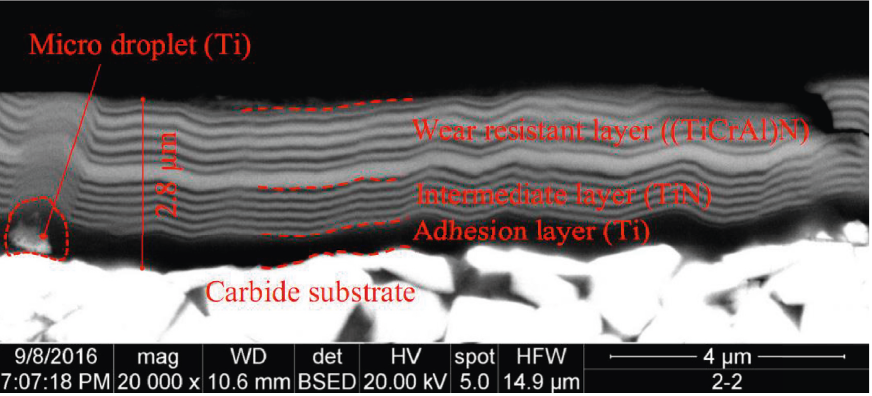
Figure 4: Structure of NMCC; Ti-TiN-(TiCrAl)N on rake face of a carbide tool deposited through the FCVAD technology